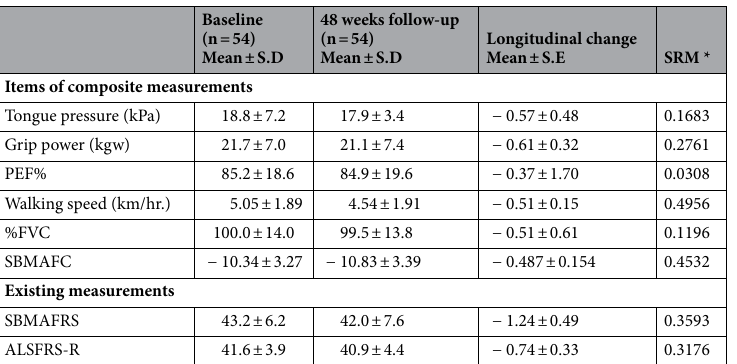
Table 2. Longitudinal change of outcome measurements in 48-week follow-up. *SRM (Standard response mean) is an index of the effect size for direct comparison among the outcome measures calculated as the ratio of the mean score change to the standard deviation of score change. A larger number indicates high sensitivity. %VC, % vital capacity; %PEF, % peak flow; SBMAFC, spinal and bulbar muscular atrophy functional composite; SBMAFRS, spinal and bulbar muscular atrophy functional rating scale; ALSFRS-R, the revised amyotrophic lateral sclerosis functional rating scale; S.D., standard deviation; S.E., standard error of the mean.